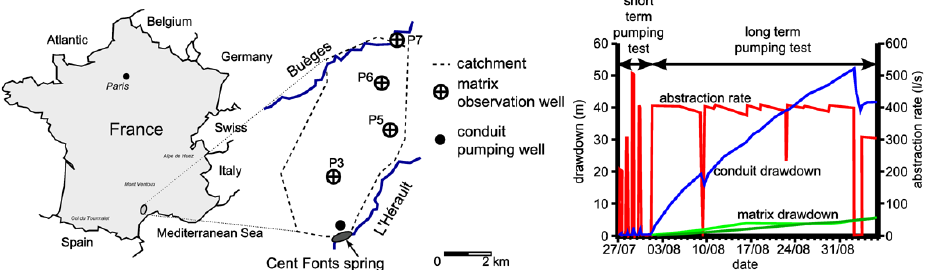
Fig. 1. Left: schematic sketch of the Cent Fonts catchment, where a large-scale and long-term pumping test was conducted (Maréchal et al., 2008); right: abstraction rate and drawdown in both matrix and conduit for a long-term and large-scale pumping test; figures from Maréchal et al. (2008).